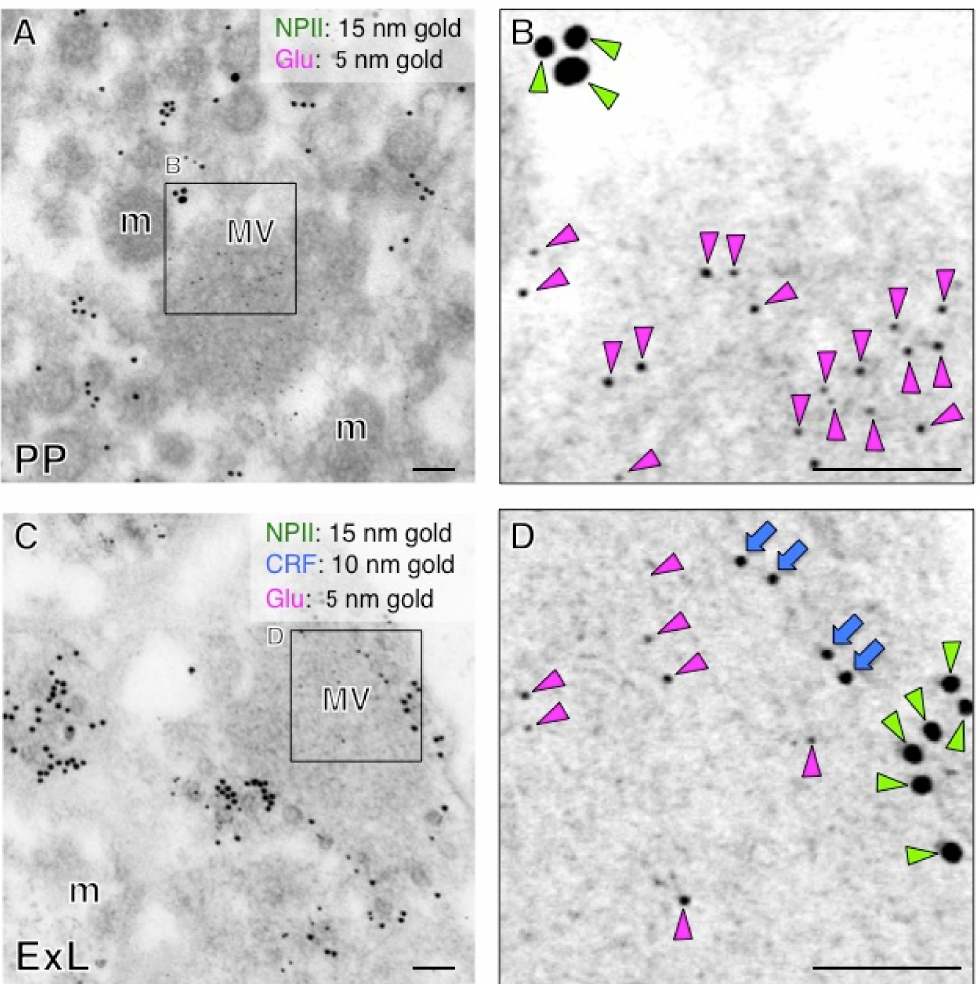
Figure 12. Immunoelectron microscopy for glutamate (Glu) in the posterior pituitary (PP) ( A ) and external layer of the median eminence (ExL) ( C ) in a macaque monkey. ( B ) Double-label immunoelectron microscopy for vasopressin-associated neurophysin (NPII) and Glu shows that Glu-immunoreactivity is associated with microvesicles in the macaque posterior pituitary. ( D ) Triple-label immunoelectron microscopy for NPII/corticotrophin-releasing factor (CRF)/Glu indicates that Glu-immunoreactivity is associated with electron-lucent small vesicles in the axonal endings, in the NPII/CRF-double positive endings. The outlined areas are enlarged. Scale bars, 100 nm. Green arrowheads indicate NPII-immunoreactivity; blue arrows indicate CRF-immunoreactivity; magenta arrowheads indicate Glu-immunoreactivity. m, mitochondrion; MV, clustered